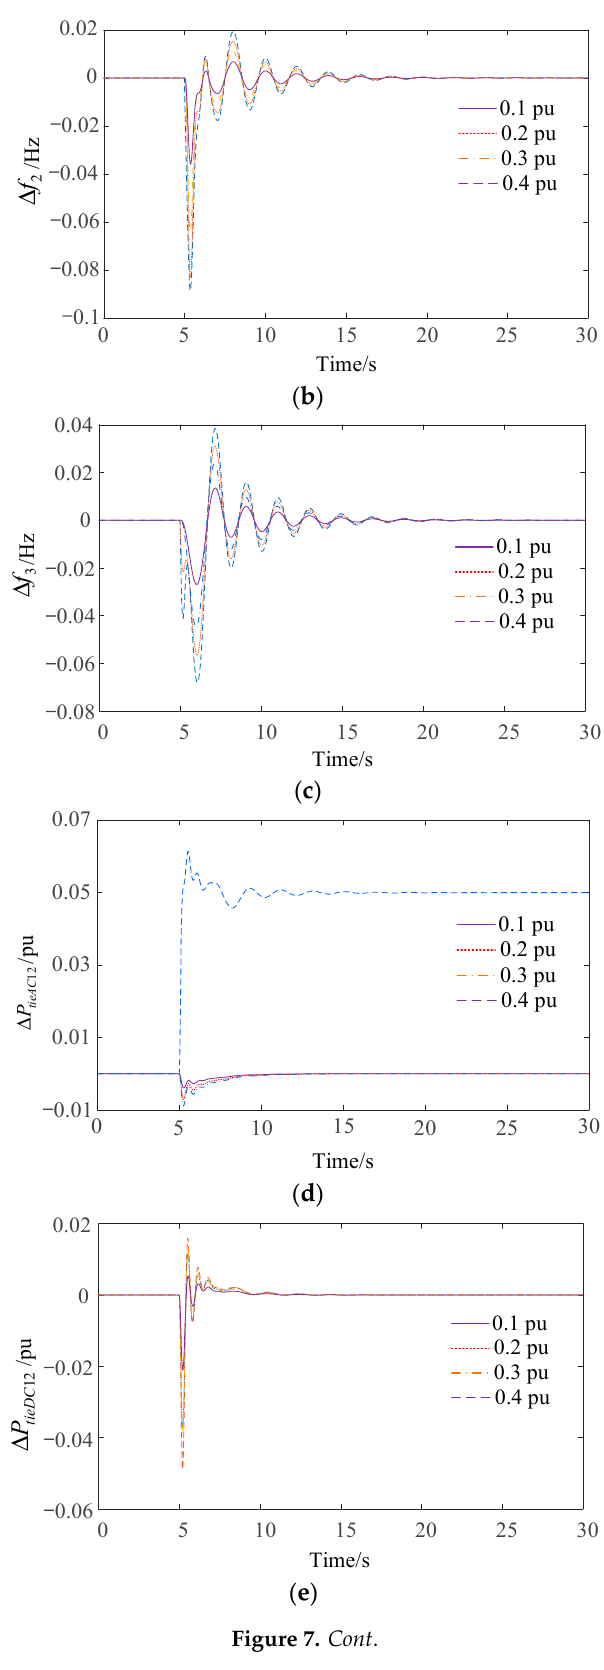
( g ) Figure 7. Dynamic time domain responses of three-area system under different load stepping disturbances: ( a ) frequency deviation of Area 1; ( b ) frequency deviation of Area 2; ( c ) frequency deviation of Area 3; ( d ) power deviation of AC tie-line 12; ( e ) power deviation of DC tie-line 12; ( f ) power deviation of AC tie-line 13; ( g ) power deviation of AC tie-line 23. 4.2. Case 2: Random Disturbance of Wind Farm The total capacity of the wind farm in Area 1 is 400 MW, accounting for 20% of the total capacity. It is assumed that the forecast deviation of wind farm output power can be estimated [37], as shown in Figure 8. For comparison, a distributed MPC method in [36] using TBC mode is considered. From the frequency deviation curve of the three-area AC/DC interconnected system shown in Figure 9, the proposed method has better dynamic response performance than the MPC using TBC mode. Compared with the MPC using TBC mode, the frequency deviation of the three-area AC/DC interconnected system always fluctuates around zero using BMPC, and the maximum deviations of the three areas are 0.018, 0.010, and 0.009 Hz. Moreover, when the random disturbance of the wind farm exceeds the lower limit of the regulation capacity of Area 1, the frequency deviation curve of the proposed BMPC control method does not show obvious sharp points around 5 min, but the